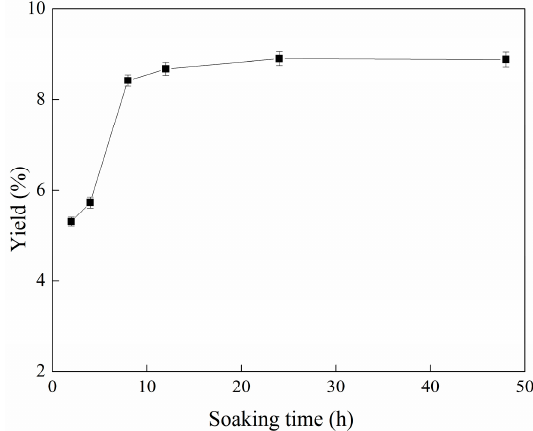
Figure 1. Relationship between soaking time and yield of C-PC. Error bars indicate standard deviations of the means ( n = 3).